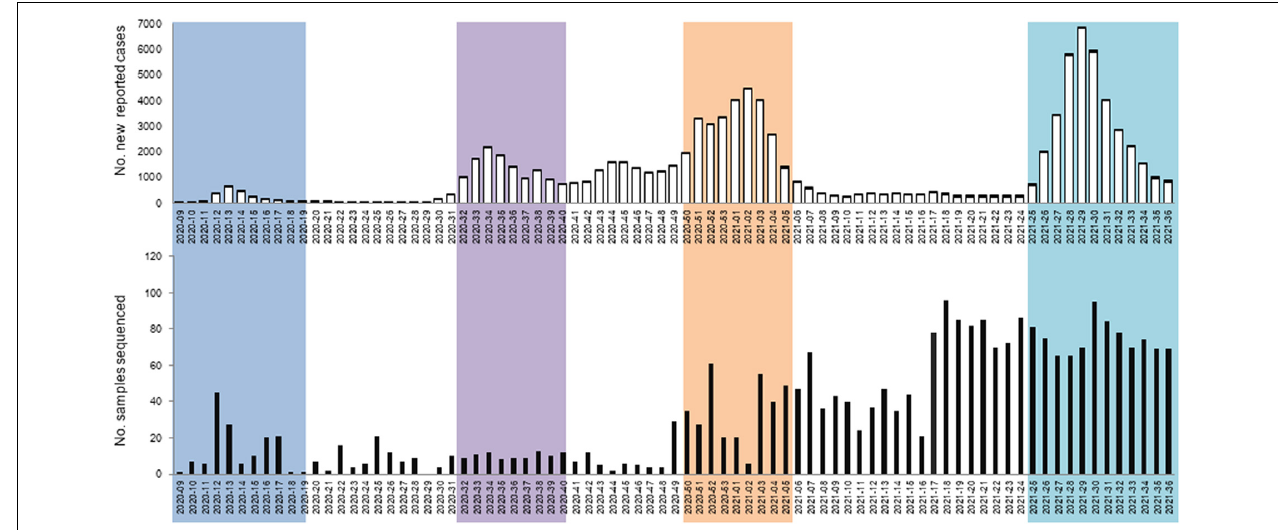
FIGURE 1 | Number of new reported cases and samples selected for sequencing by epidemiological week. Epidemic waves in the Balearic Islands are indicated in colors: dark blue (1st epidemic wave), purple (2nd epidemic wave), orange (3rd epidemic wave), and light blue (4th epidemic